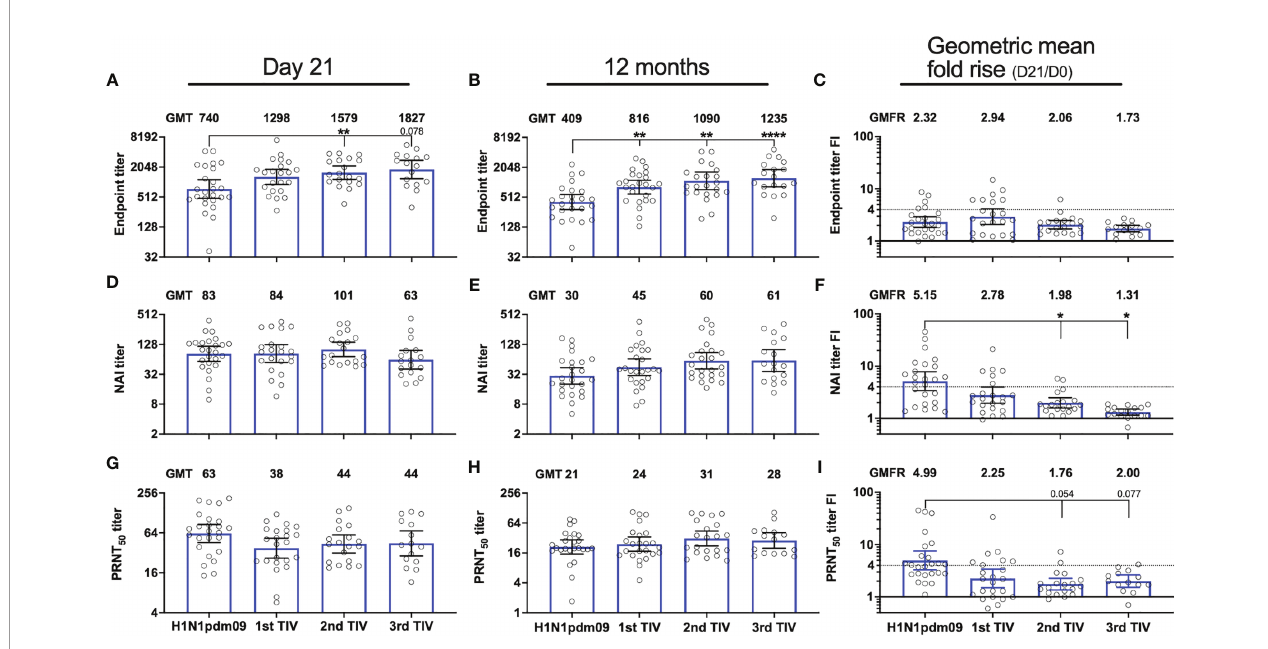
FIGURE 4 | Repeated in fl uenza vaccination boosted durable NA-speci fi c antibody titers but with diminished fold-induction. NA-speci fi c antibody responses were measured 21 days and 12 months after vaccination with AS03-adjuvanted monovalent H1N1pdm09 vaccine and three trivalent in fl uenza vaccines (TIVs) in the four subsequent years after the 2009 pandemic. Antibody titers were measured by ELISA (A, B) , ELLA (D, E) and plaque reduction neutralization assay (G, H) in the repeated group. Geometric mean titers (GMT) are indicated for each vaccine on top of all graphs (A, B, D, E, G, H) . Fold-increase (FI) for each subject on day 21 (day 21/day 0) was calculated for the individual vaccines and the geometric mean fold rise (GMFR) for the whole group is indicated on top of each graph (C, F, I) . The dotted line represents the threshold set for seroconversion (>4-fold increase). Results are grouped by H1N1pdm09 vaccination and number of trivalent in fl uenza vaccines (TIV) received. The data are presented as geometric mean with 95% con fi dence intervals. A linear mixed effects model with adjustments for demographic factors was used to determine statistical difference between antibody titers measured after vaccination with H1N1pdm09 and TIVs. *P ≤ 0.05, **P ≤ 0.01, ****P ≤